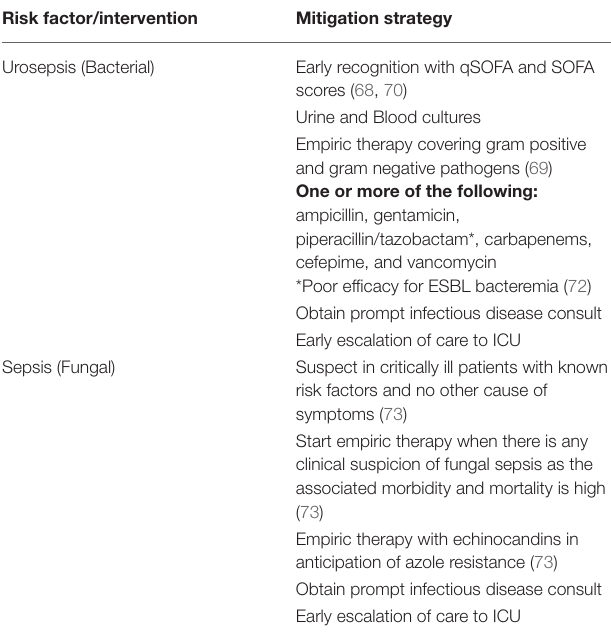
TABLE 3 | Summary of post-operative considerations. Risk factor/intervention Mitigation